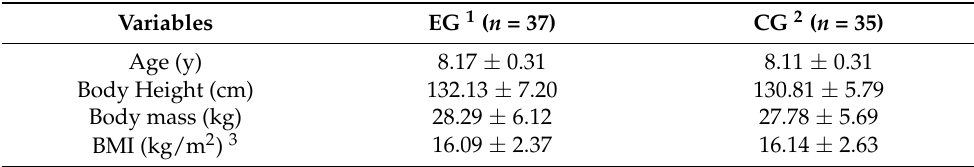
Table 1. Participants